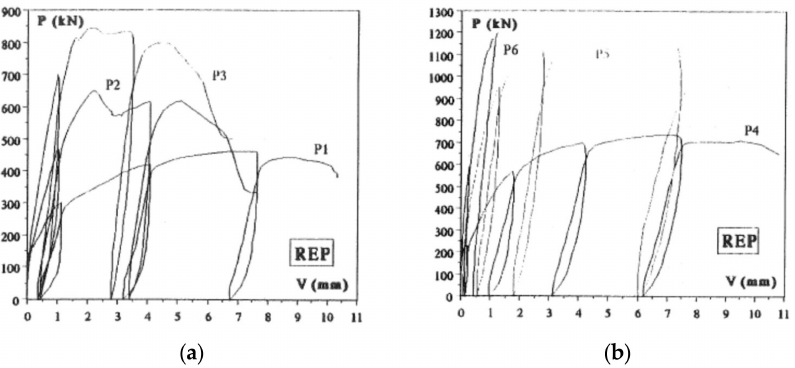
Figure 5. Load-slip curve obtained by Puhali and Smotlack [4] for: ( a ) group A specimens; ( b ) group B